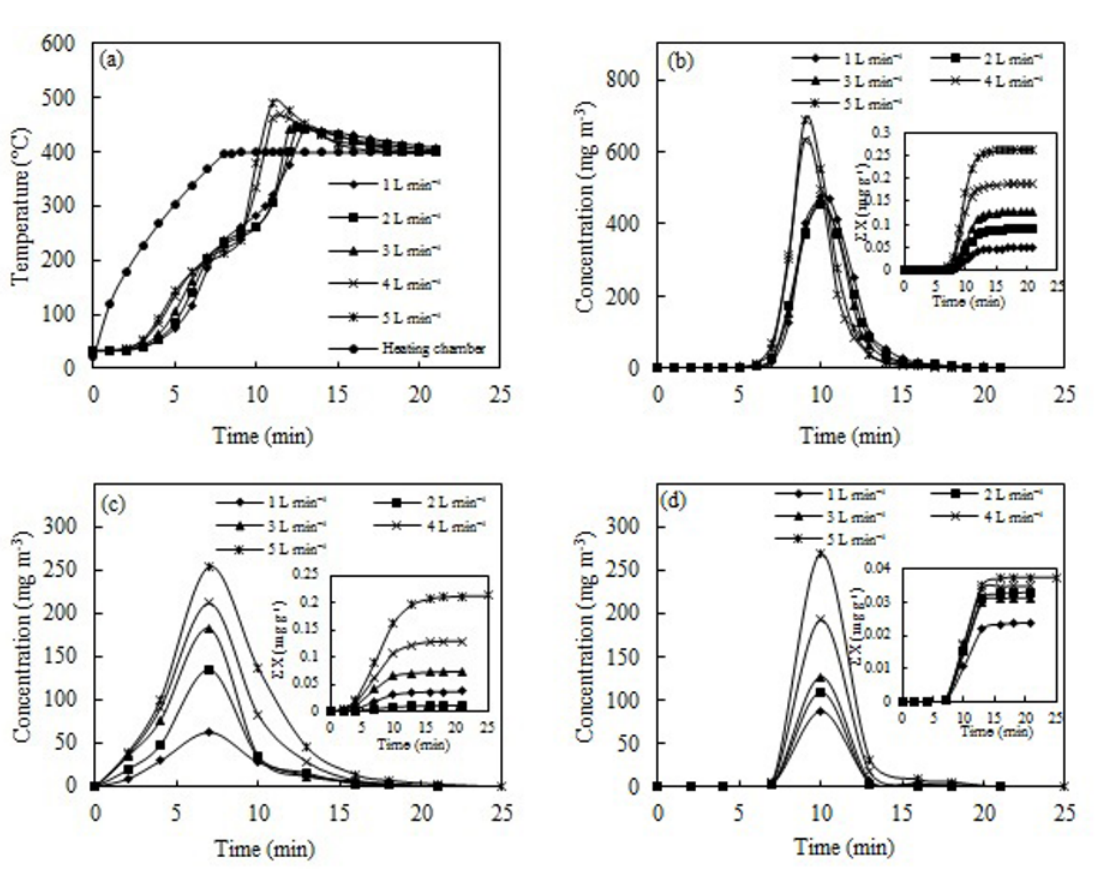
Figure 3. Temperature swing oxidation of toluene at different regenerative air flow rates: (a) temperature profiles of reactor and heating chamber; (b) evolution of CO; (c) thermal runaway of toluene; (d) evolution of benzene; insets - integral amounts ( Σ X) of desorbed/formed